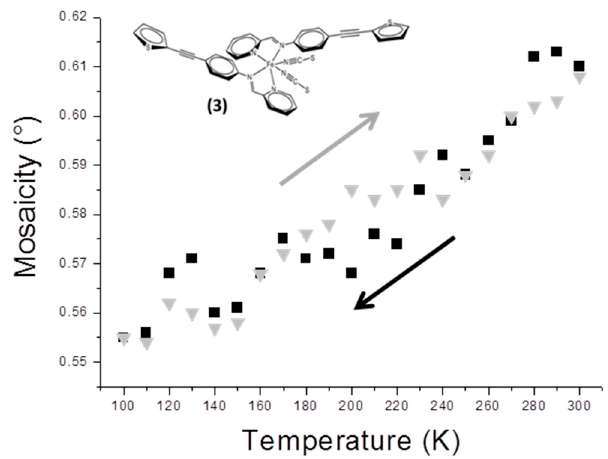
Figure 3. Temperature dependence of the mosaicity for a crystal of [Fe(PM-TheA) 2 (NCS) 2 ]-II in the cooling (black squares) and warming (light-grey triangles) modes.